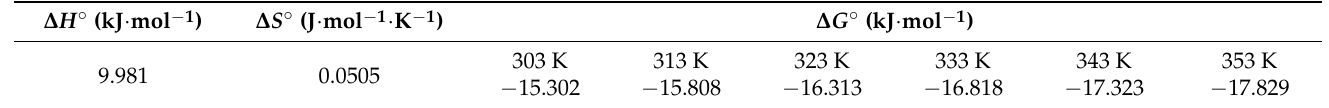
Table 2. Thermodynamic parameters acquired from Cd 2+ extraction temperature